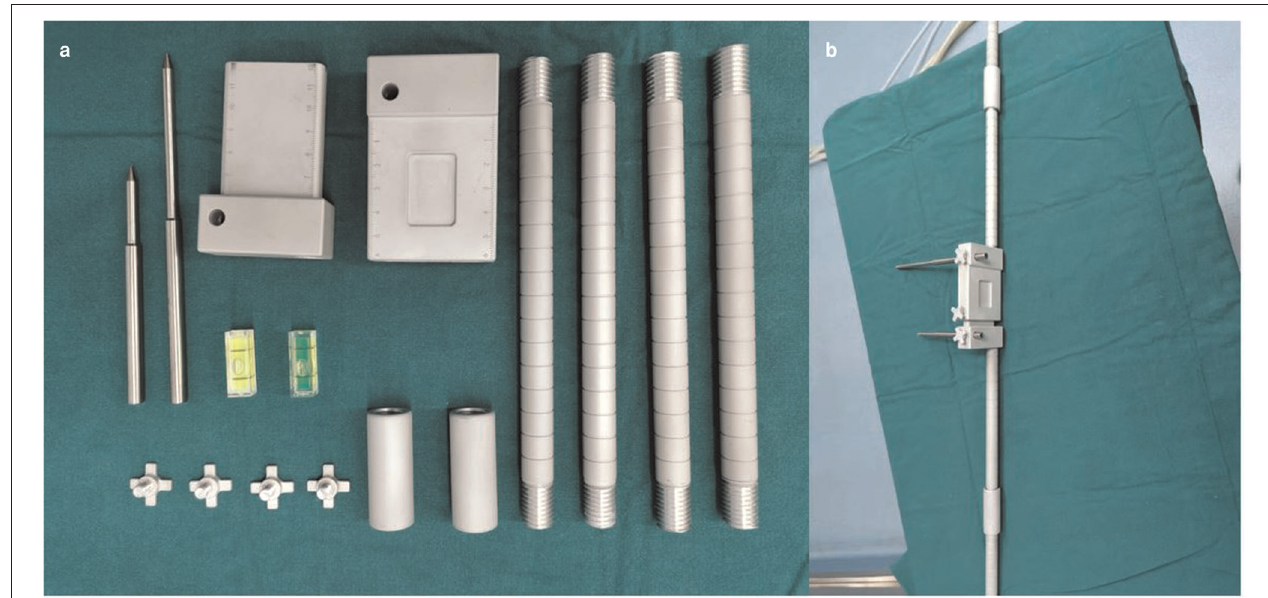
FIGURE 4 | Physical diagram of the horizontal calibrator. (a) Shows all the components of the horizontal calibrator. See Figure 3 for details. (b) Shows the complete connected physical diagram of the horizontal calibrator, which was reserved preoperatively. Group II ( p = 0.08; 95%CI = − 5.7, 12.9) were 83.4 ± 24.3 min and 79.8 ± 19.5 min, respectively, without statistical significance ( Table 1 ). The preoperative radiographic LLD of Group I (mean ± SD = 9.6 ± 7.1 mm, range − 51.0 to 19.7 mm) and Group II (mean ± SD = 10.0 ± 8.8 mm, range − 21.9 to 32.0 mm) were examined by the independent T -test, and the data ( p =